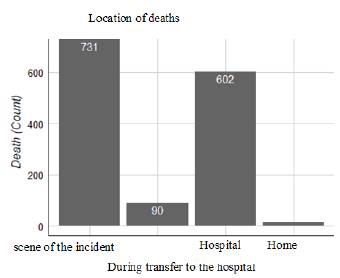
Figure 2. The mortality rate of road traffic accidents according to the location of deaths during 2011-2015.